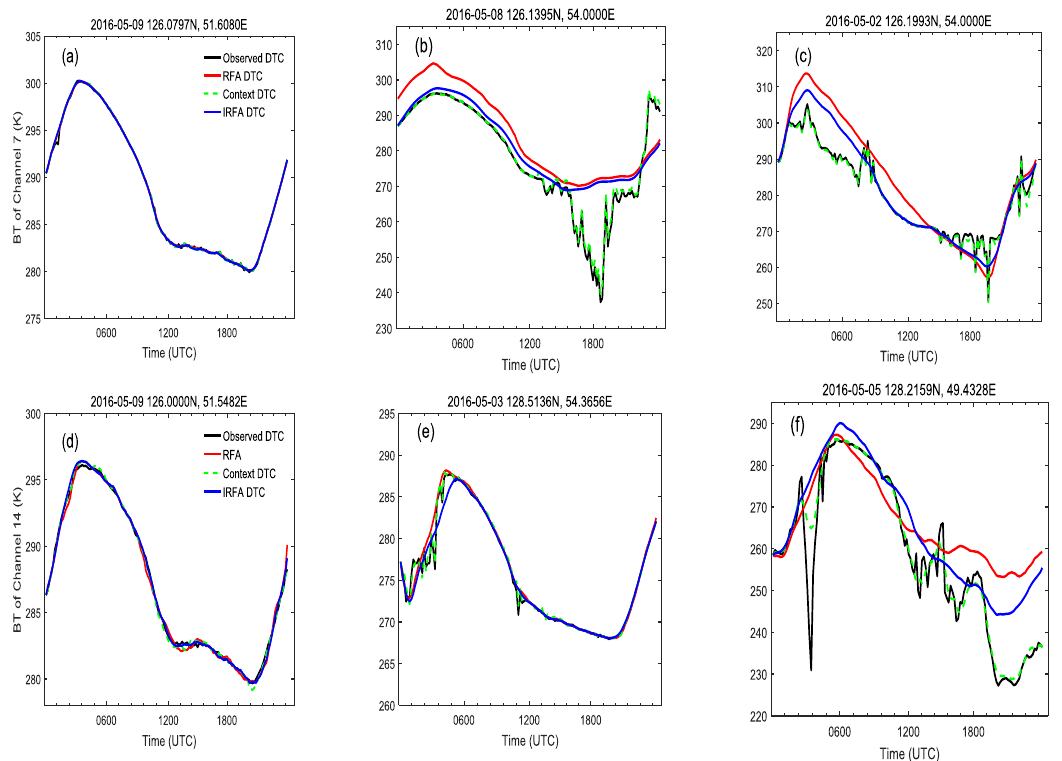
Figure 5. Examples of Diurnal Temperature Cycle (DTC) model fitting using the three methods in MIR and LWIR bands. ( a , d ) shows a typical day with less than 30 fire-affected and cloud-affected values, ( b , e ) show a day with between 90–120 cloud- and fire-contaminated observations, and ( c , f ) are typical of a day with more than 120 identified cloud- or fire-affected periods. “RFA” and “IRFA” denote the robust fitting algorithm and improved robust fitting algorithm respectively.